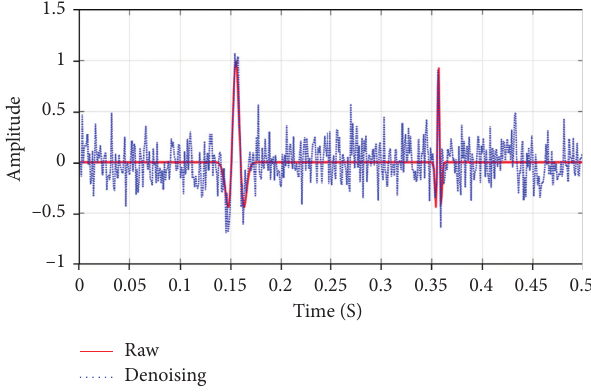
Figure 2: Synthetic data with